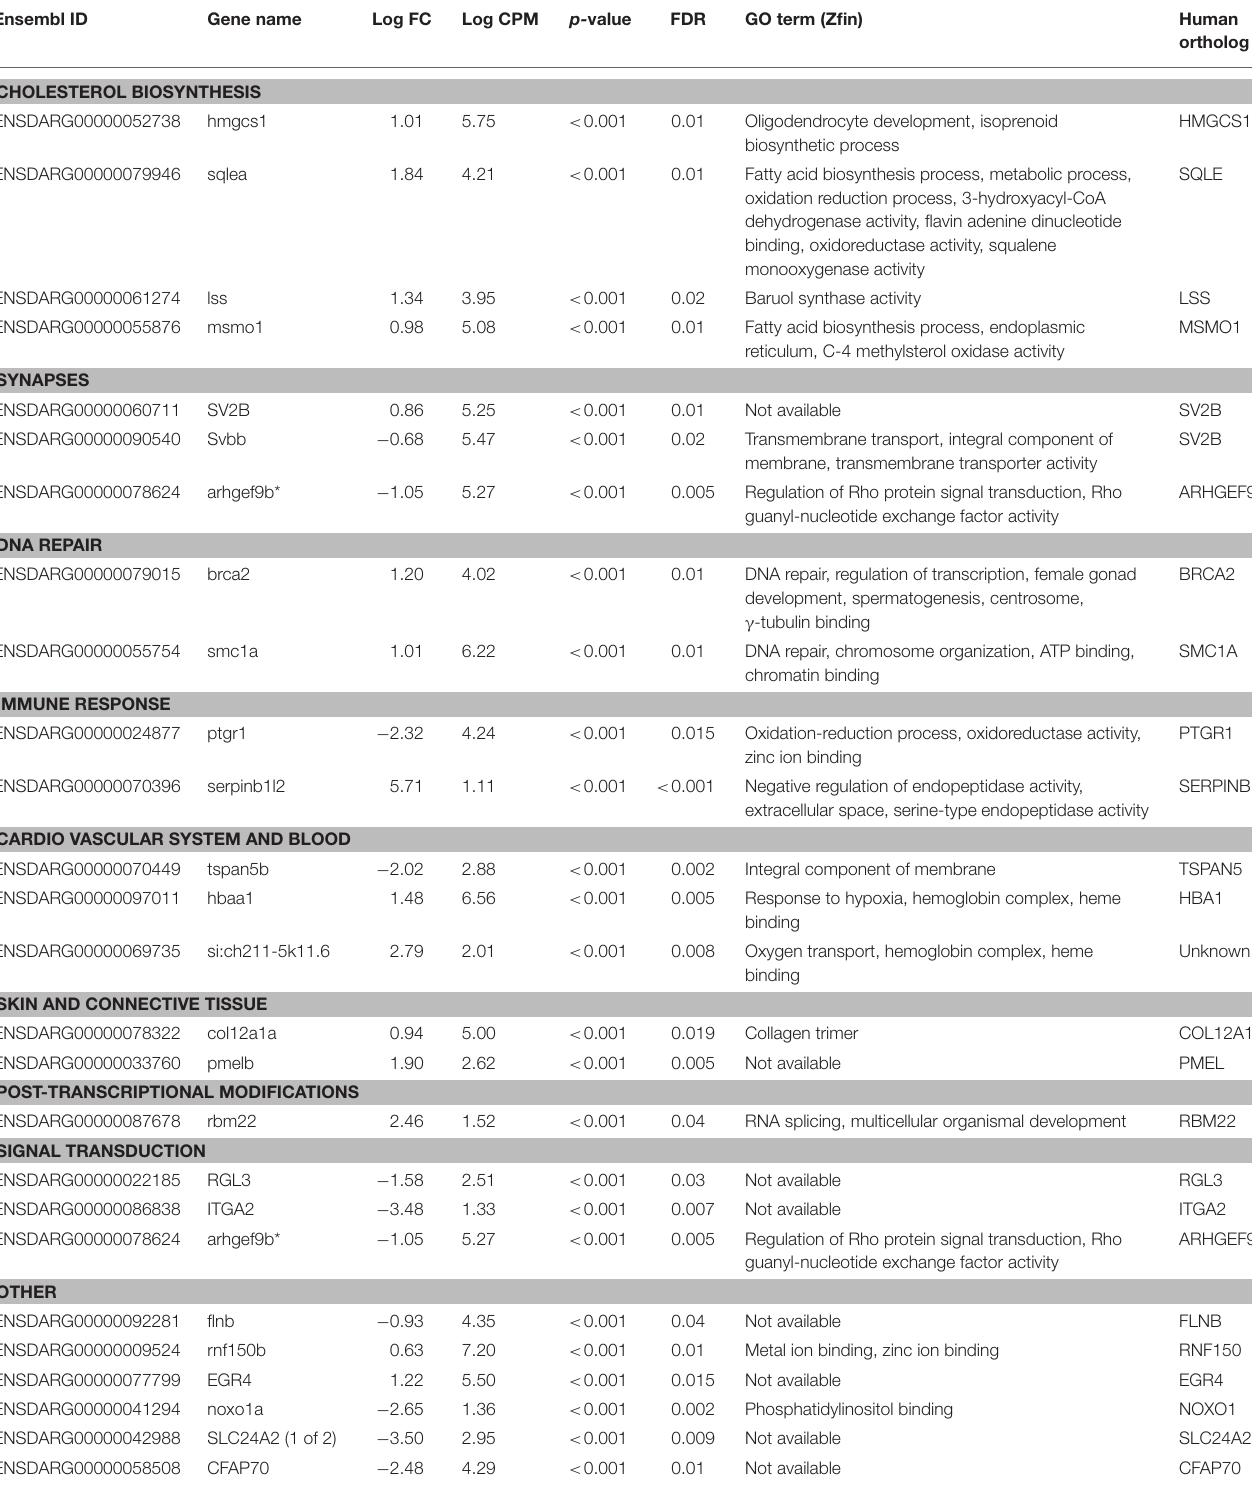
TABLE 5 | List of protein coding genes significantly affected in brains of male zebrafish developmentally exposed to 3ng/L EE 2 compared to non-exposed fish after 120 days of recovery in clean water. Ensembl